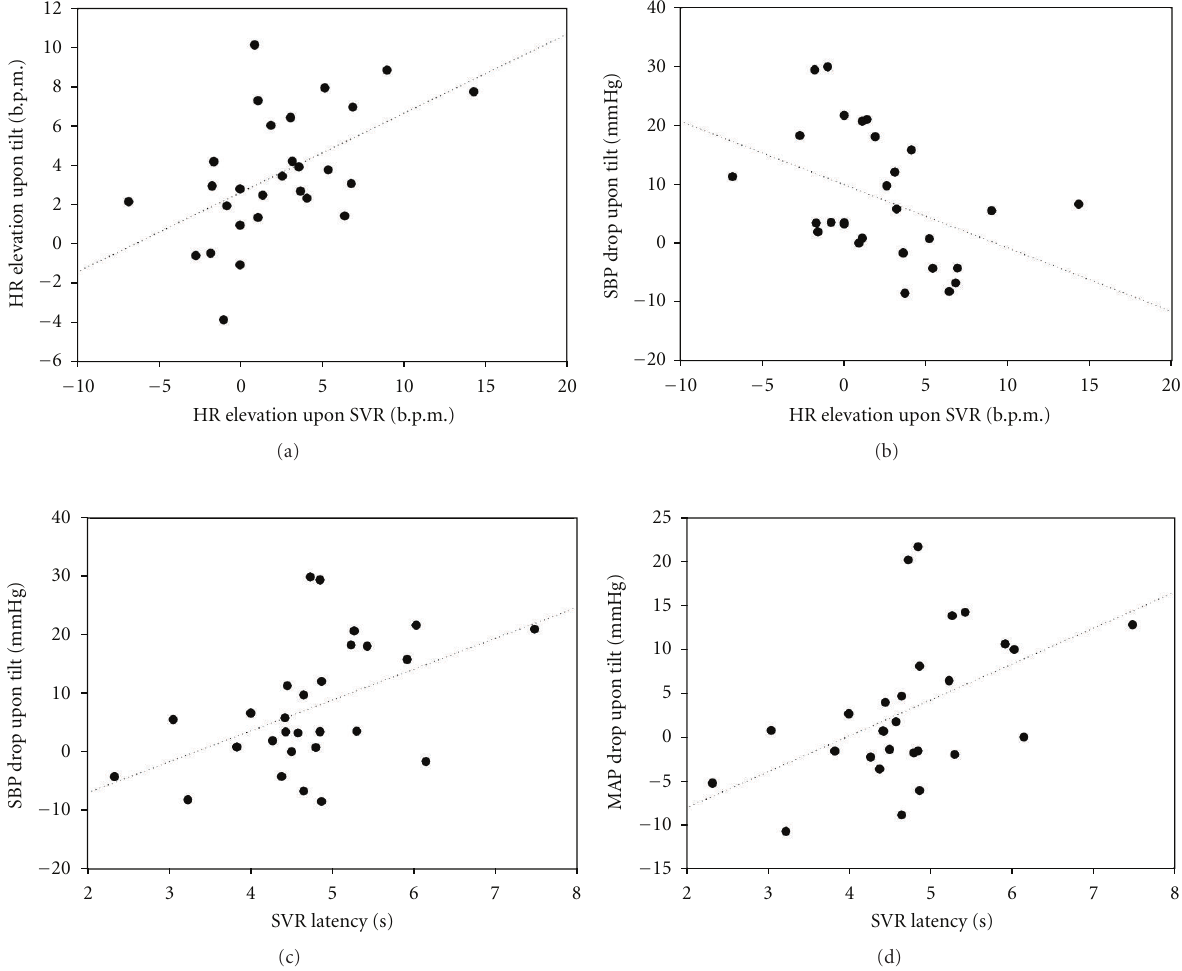
Figure 3: The correlation analysis of hemodynamic variables between SVR and the tilt table study. (a) The HR elevation upon SVR correlated positively with the HR elevation upon head-up tilt ( r = 0 . 520, P = 0 . 005) but (b) negatively with the SBP drop from supine to tilt ( r = − 0 . 414, P = 0 . 029). The SVR latency demonstrated a positive correlation with (c) the SBP drop and (d) MAP drop after tilting up ( r = 0 . 486, P = 0 . 009 and r = 0 . 5, P = 0 . 007, resp.). Note: SVR: sympathetic vasomotor response; HR: heart rate; SBP: systolic blood pressure; MAP: mean arterial